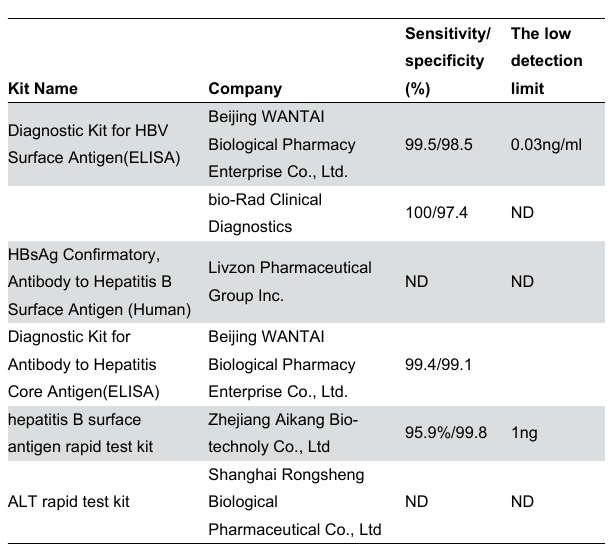
Table 1. Test kits used in this